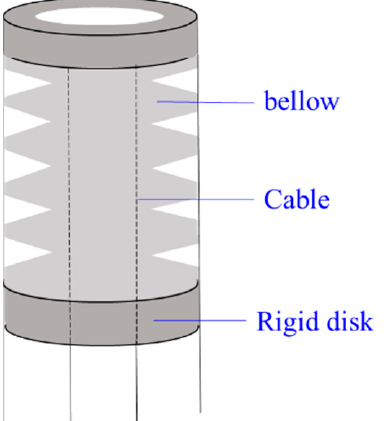
Figure 9. A bellow CCR with cable-driven system [99].